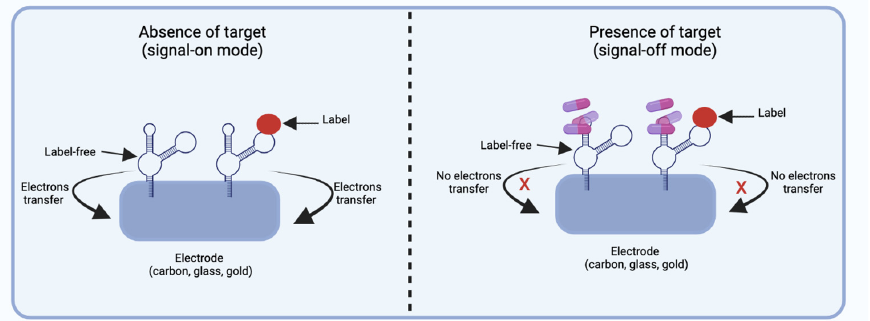
Figure 6. Schematic representation showing the operation of an electrochemical aptasensor in two different events (signal-on mode and signal-off mode). Signal-on mode occurs in the absence of the target; labeled and unlabeled aptamers are immobilized on the electrode surface, promoting electron transfer. Contrarily, in signal-off mode, the immobilized aptamers (labeled and label-free) interact with the target causing the inhibition of electron transfer. Created with BioRender.com.